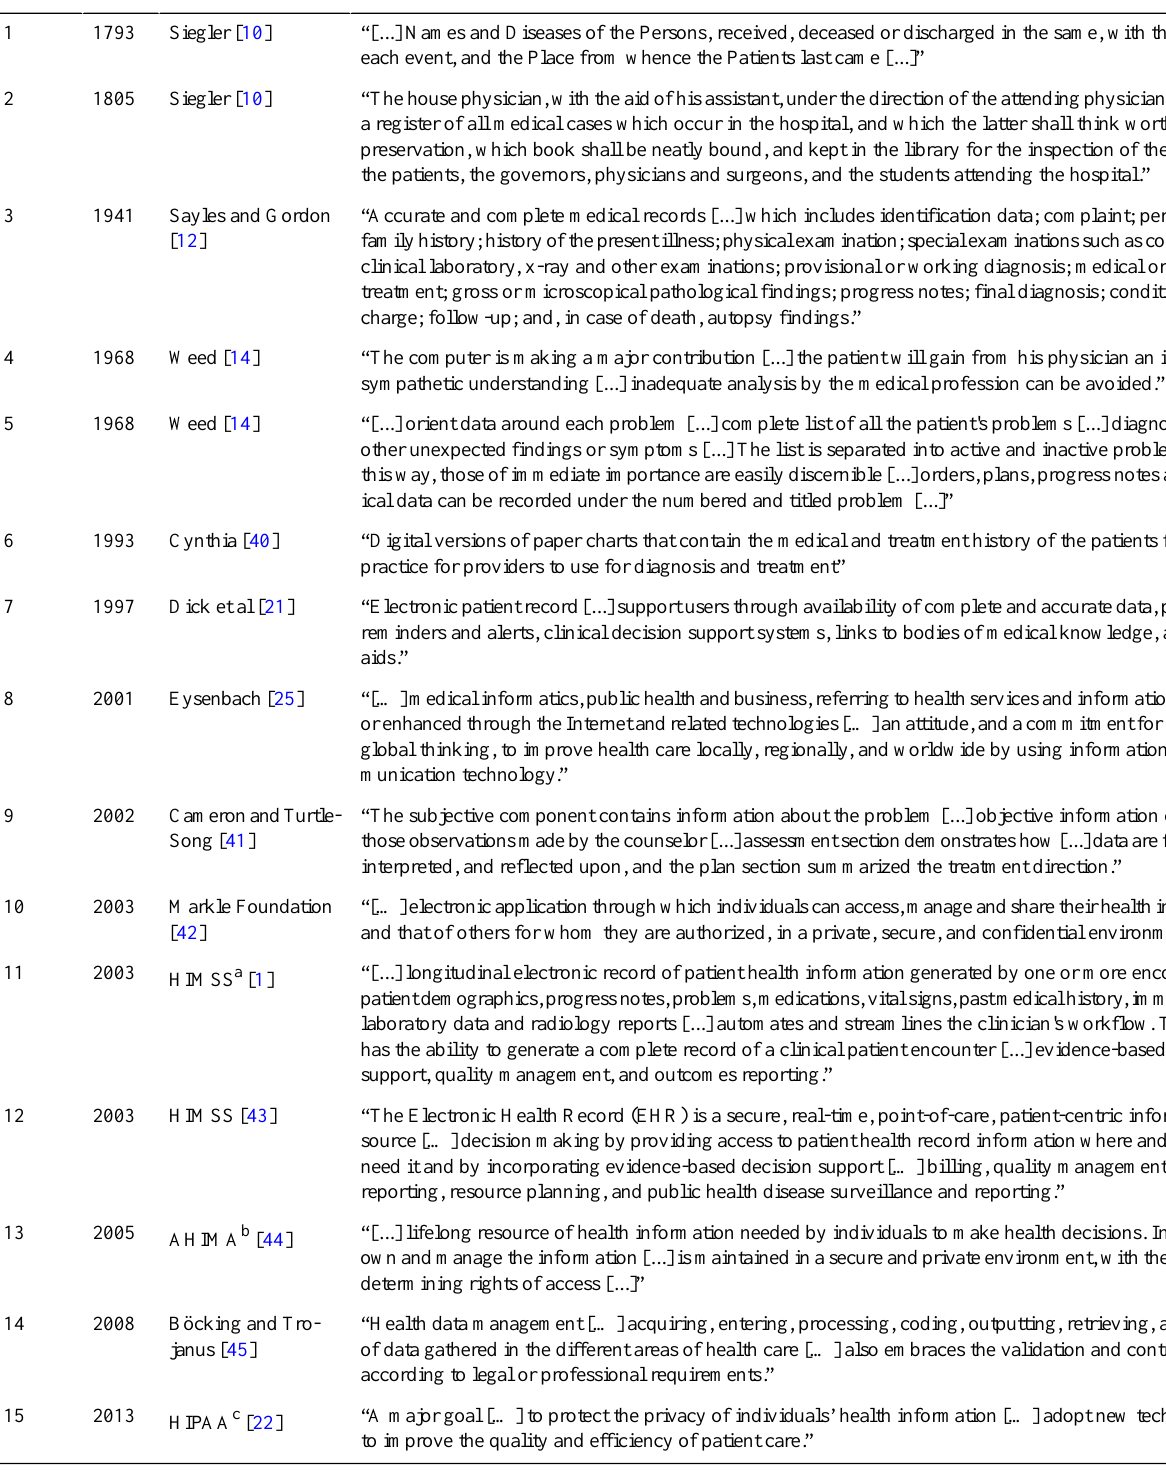
Table 3. The definitions of health data management systems.